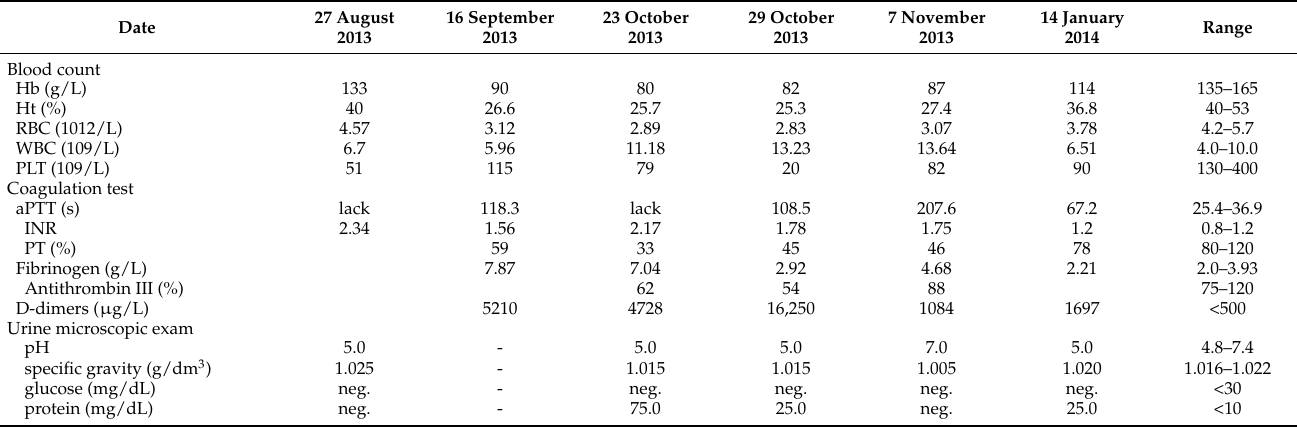
Table 1. Laboratory test results—blood morphology, urinalysis, biochemical and immunological test